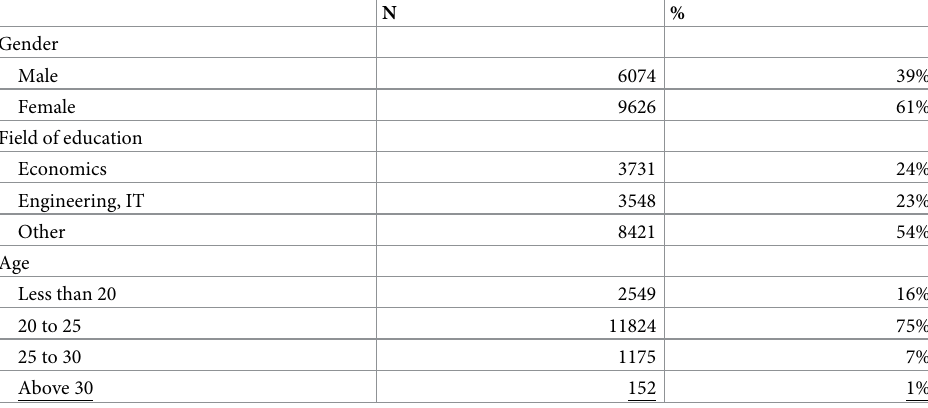
Table 1. Statistical characteristics of the